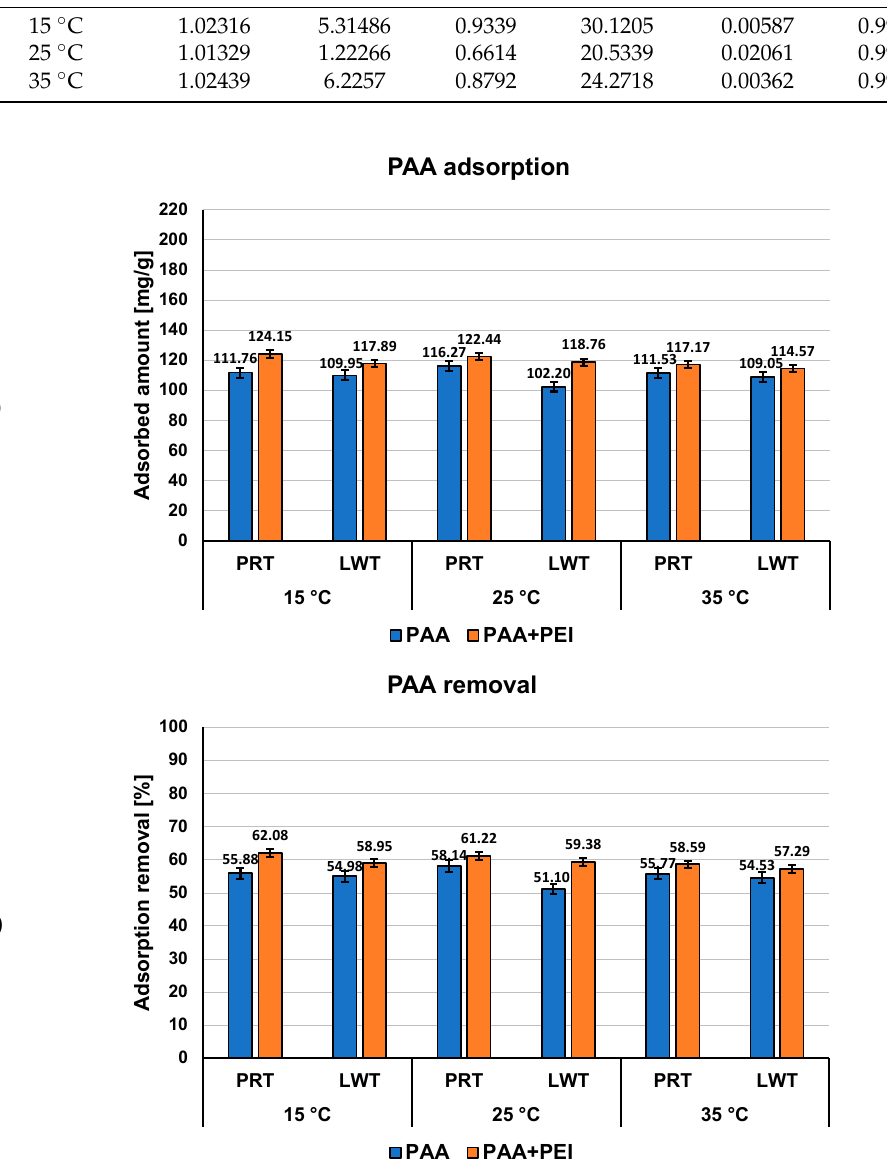
Figure 4. PAA adsorbed amounts ( a ) and its percentage removal ( b ) from the commercial materials surface in single and mixed systems of adsorbates at three examined temperatures, pH 3.